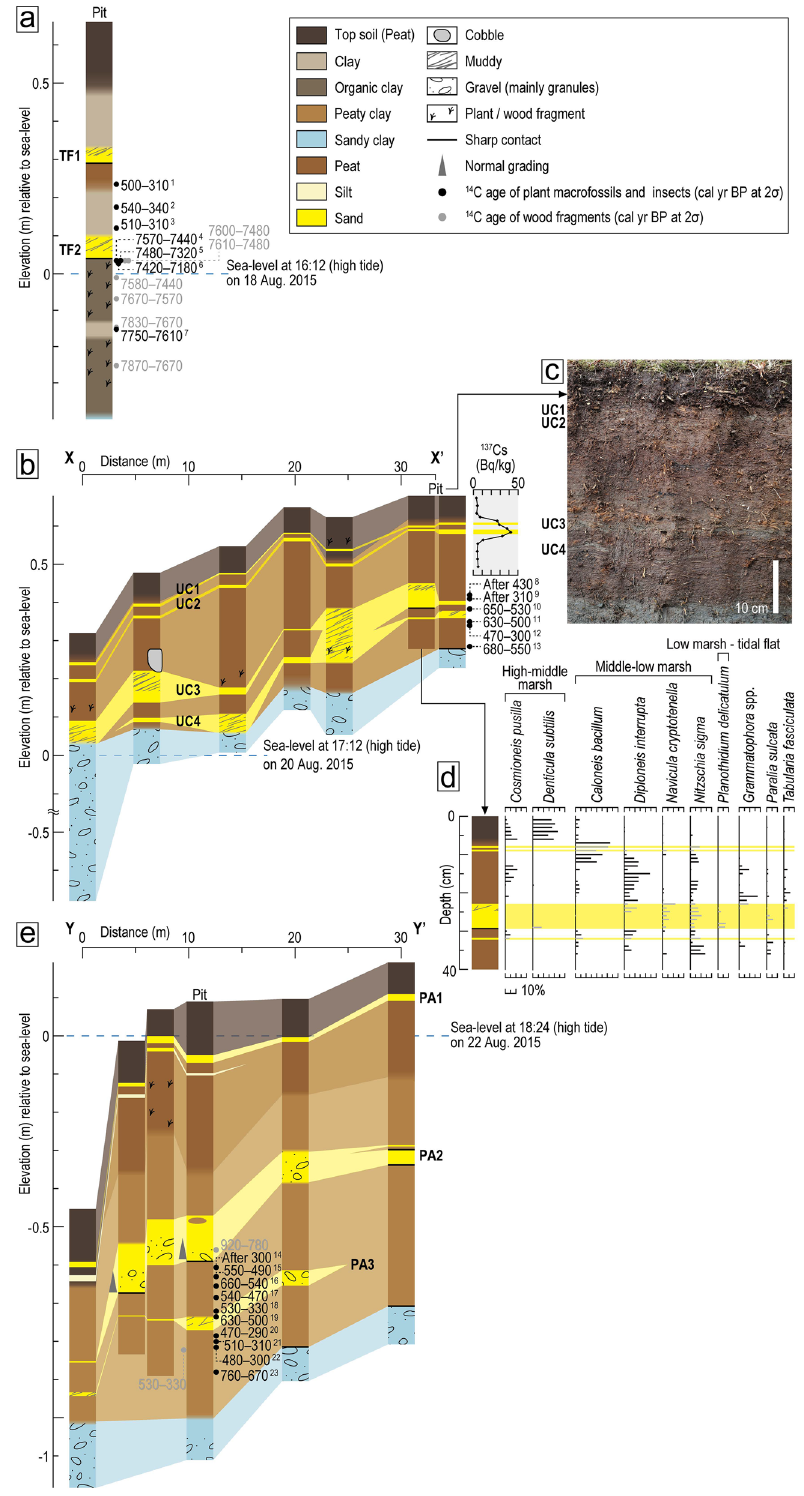
Figure 2. Stratigraphic evidence from study sites. ( a ) Tofino pit lithology (see Fig. 1b for location) and chronology. Details of radiocarbon ages are given in Supplementary Table S1. Numerical superscripts following radiocarbon ages correspond to the sample numbers in Fig. 3 and Table S1. ( b ) Stratigraphic cross-section along transect X-X’ in Ucluelet (see Fig. 1c for location) showing radiocarbon ages (Supplementary Table S1) and vertical distribution of 137 Cs. Numerical superscripts following radiocarbon ages correspond to the sample numbers in Fig. 3 and Table S1. ( c ) Photograph of Ucluelet pit wall. ( d ) Relative abundance of selected brackish-marine diatom species from the Ucluelet pit. Gray bars indicate assemblages within sand sheets UC1–4 (full diatom assemblage in Supplementary Fig. S1). ( e ) Stratigraphic cross-section along transect Y-Y’ in Port Alberni (see Fig. 1d for location) showing radiocarbon ages (Supplementary Table S1). Numerical superscripts following radiocarbon ages correspond to the sample numbers in Fig. 3 and Table